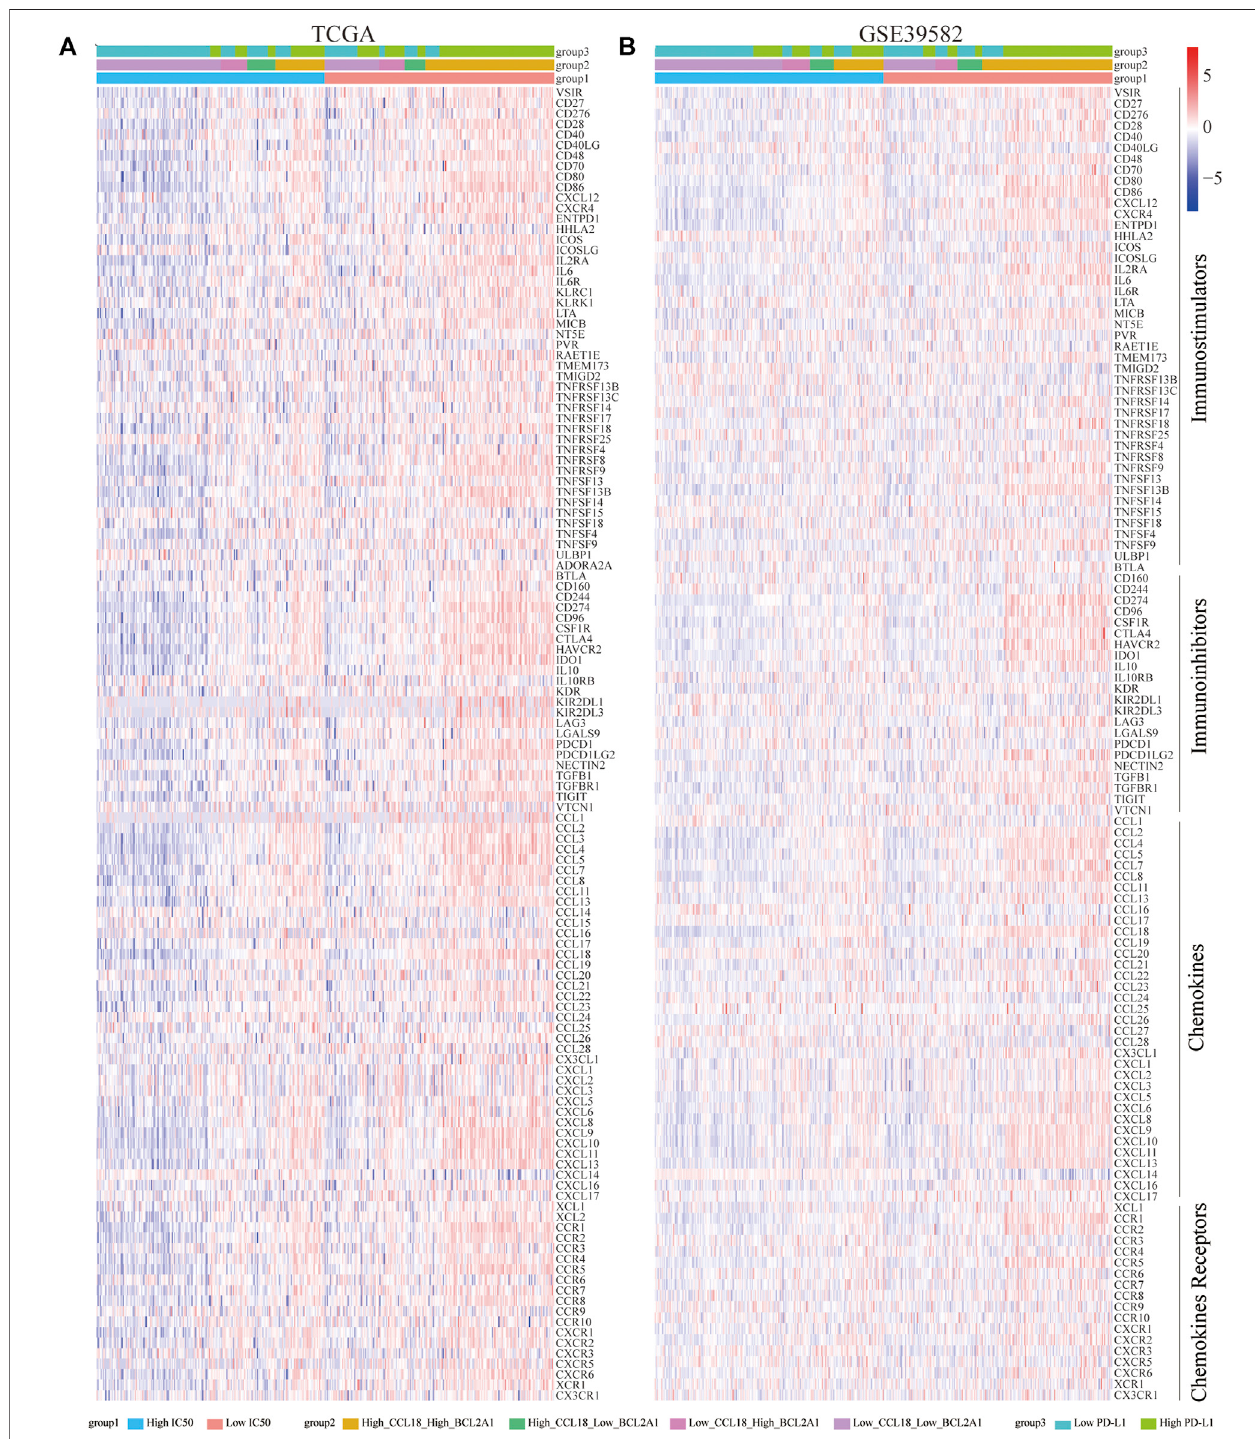
FIGURE 9 | Correlation of immunomodulators (immunostimulators, immunoinhibitors, chemokines, and chemokine receptors). In (A) TCGA and (B) GSE39582, most immunomodulators were signi fi cantly upregulated in the low-IC50 group and High_CCL18_High_BCL2A1 group.